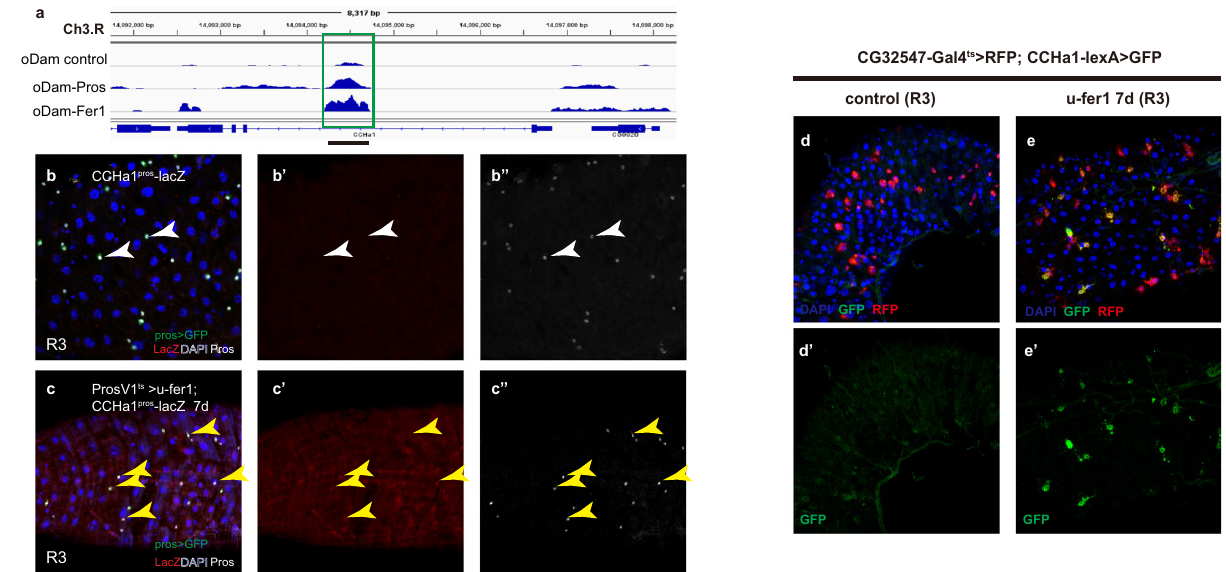
Fig. 6 | The 3 o TF Fer1 is a determinant of sub-class EE subtypes. a The putative ProstargetingregiononCCHa1loci(alsotheregionusedtogenerateCCHa1 pros -lacZ reporter)isalsotargeted by Fer1,asindicated bythe signi fi cantpeakof oDam-Fer1 on the underlined region; b , c the CCHa1 pros -lacZ reporter is responsive to ectopic Fer1 activation. In normal guts, CCHa1 pros -lacZ reporter is not expressed in R3 EEs